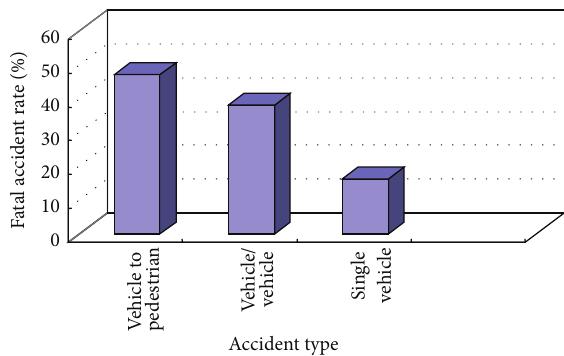
Figure 3: Fatal rate according to highway type.